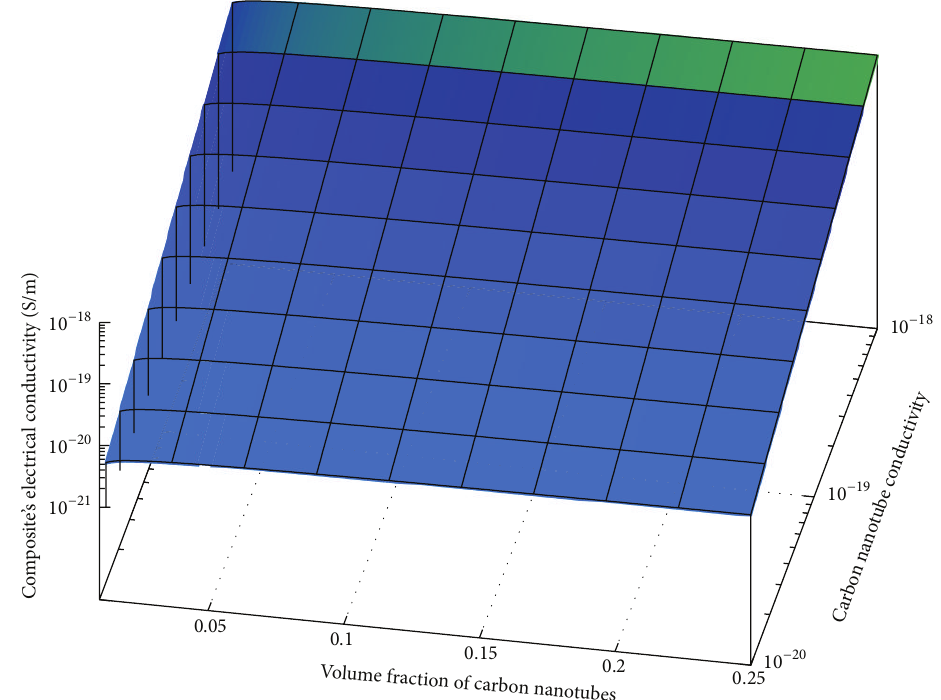
Figure 8: DC electrical conductivity of the nanocomposite when both the conductivity of the filler and the volume fraction of the filler are varied (Kirkpatrick’s